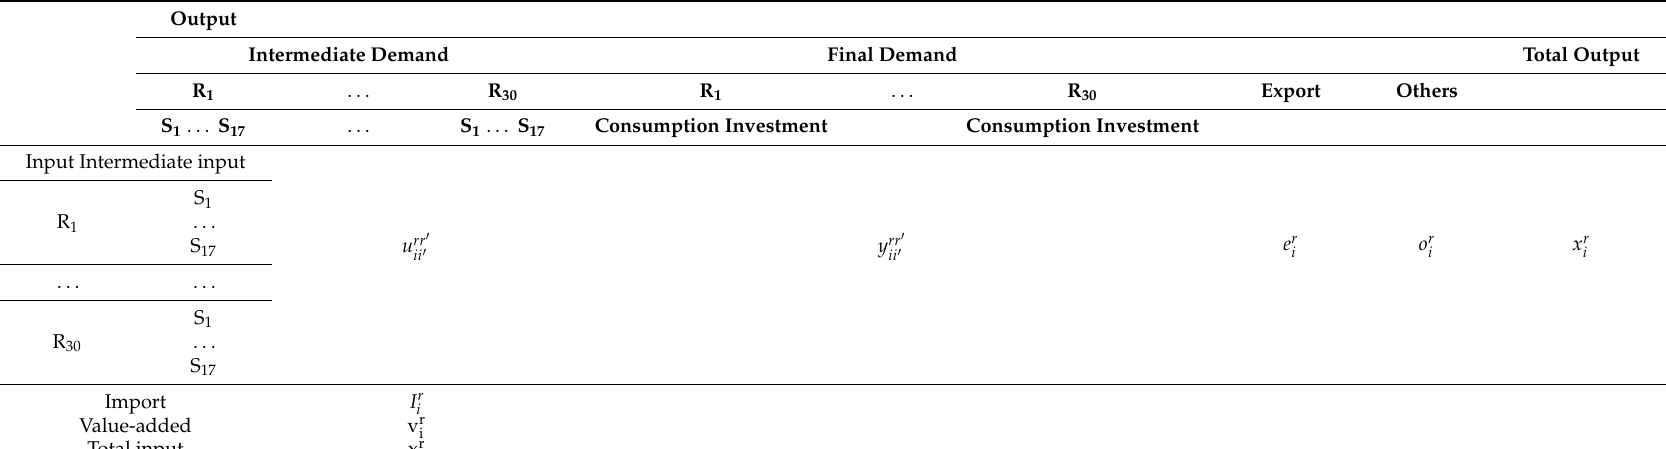
Table 1. The MRIO table for China in